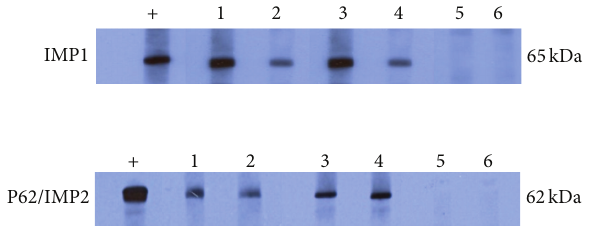
Figure 2: Western blotting analysis showing representative ovarian cancer sera recognizing IMP1 and p62/IMP2 recombinant proteins. Themonoclonalanti-IMP1andanti-p62/IMP2antibodieswereused as positive controls; lanes 1–4, four representative ovarian cancer sera that were positive in ELISA test and also have strong reactivity with IMP1 and p62/IMP2 recombinant proteins in Western blotting analysis;lanes5and6,normalhumanserathatwereusedasnegative